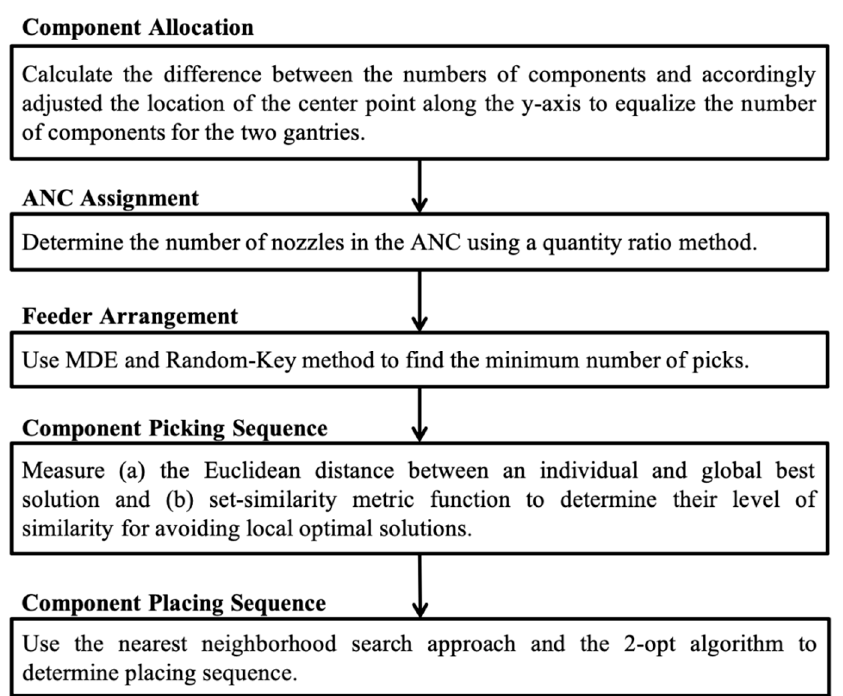
Figure 5. Research flow chart.